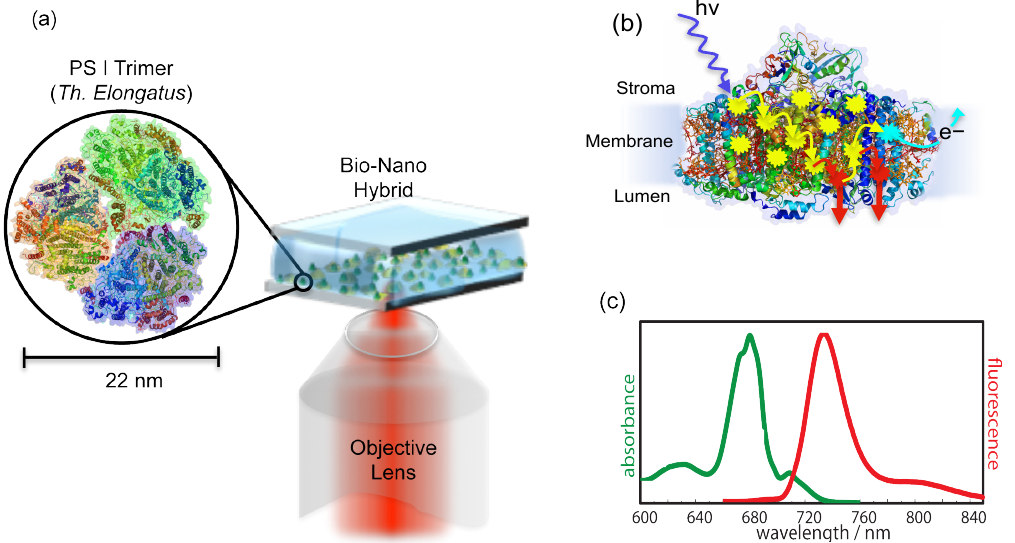
Figure 2. ( a ) Schematic illustration of experimental arrangement. A buffer solution containing isolated and purified photosystem I (PSI) trimers from T h. elongatus is sandwiched between metallic nanostructures and a bare glass coverslip. The green dots represent PSI trimers, while random yellow dots are metallic nanostructures. The inset shows the trimeric PSI from T h. elongatus (protein data bank (PDB) entry: 1JB0). The same objective is used for the excitation and collection of back reflected light. ( b ) The transfer (EET)